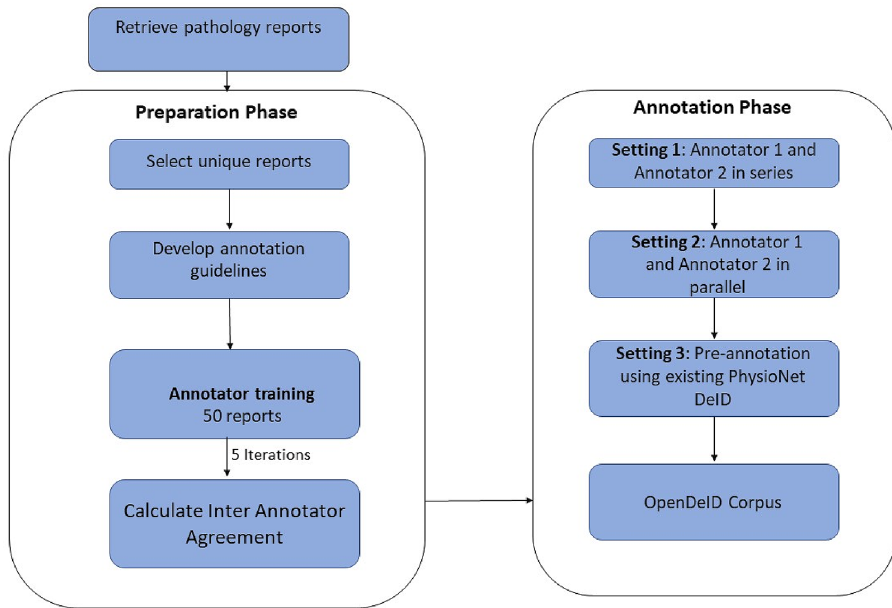
Figure 1. Overall OpenDeID corpus construction